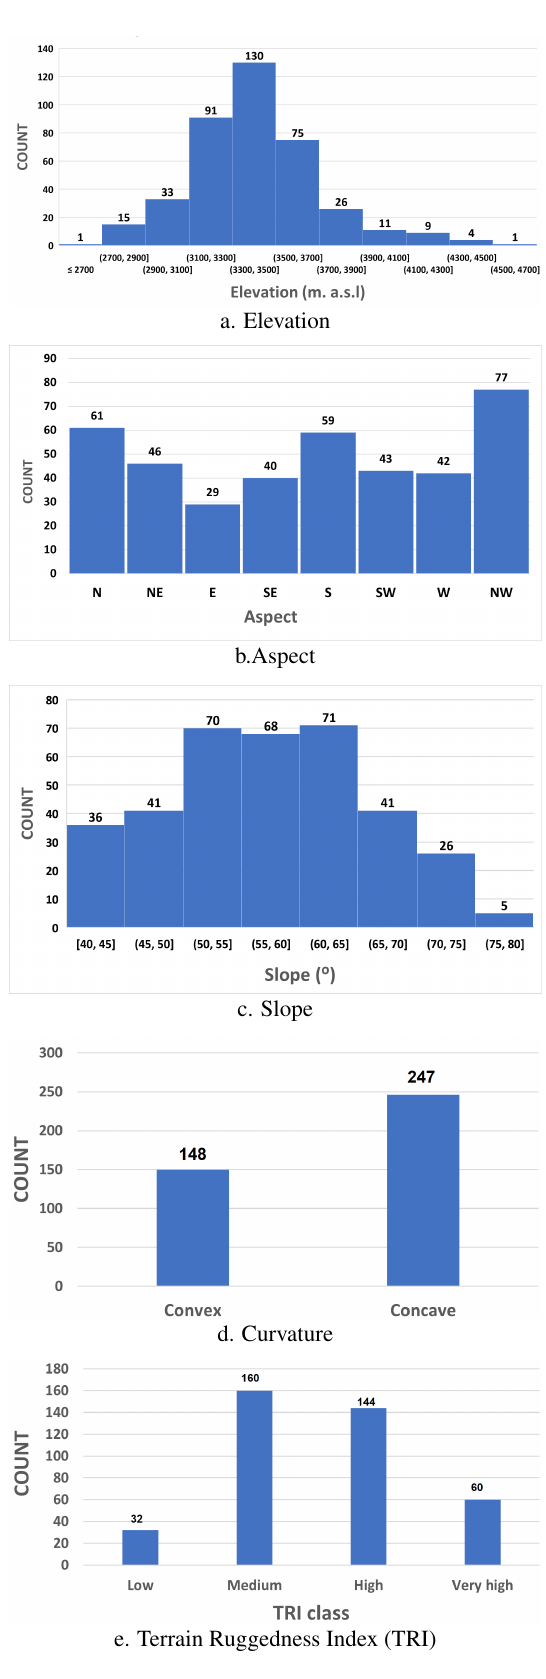
Figure 4. Distribution of Ice Aprons based on different topographic parameters